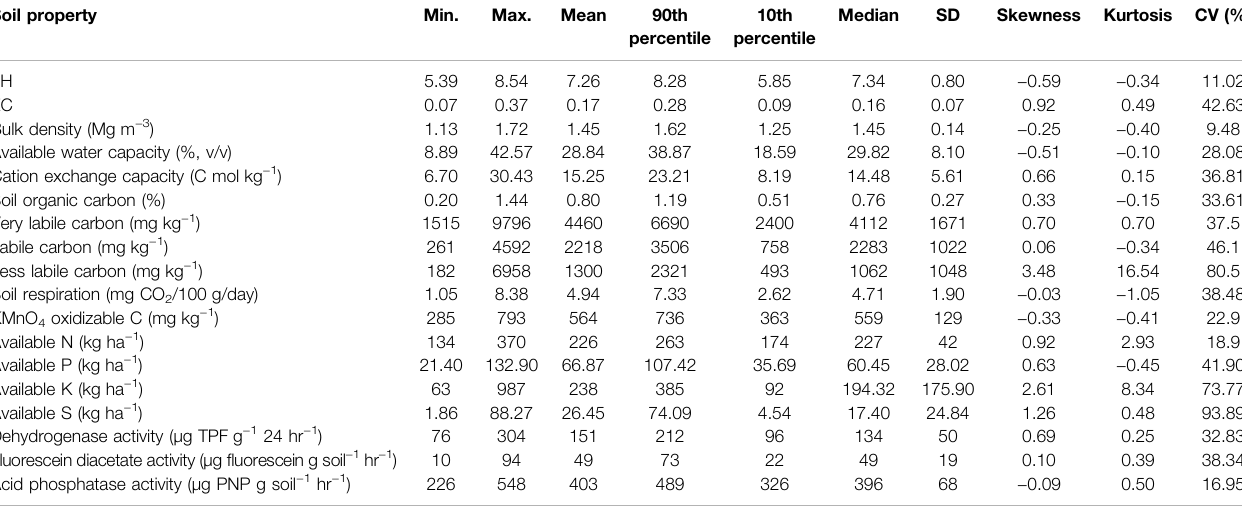
TABLE 2 | Descriptive statistics of soil properties of 0 – 15 cm depth used for soil quality assessment ( n = 156). Soil property Min.